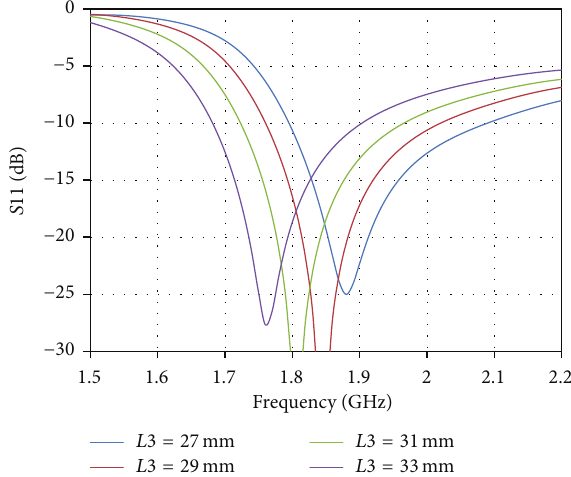
Figure 4: Parametric study on the influence of 𝐿3 .